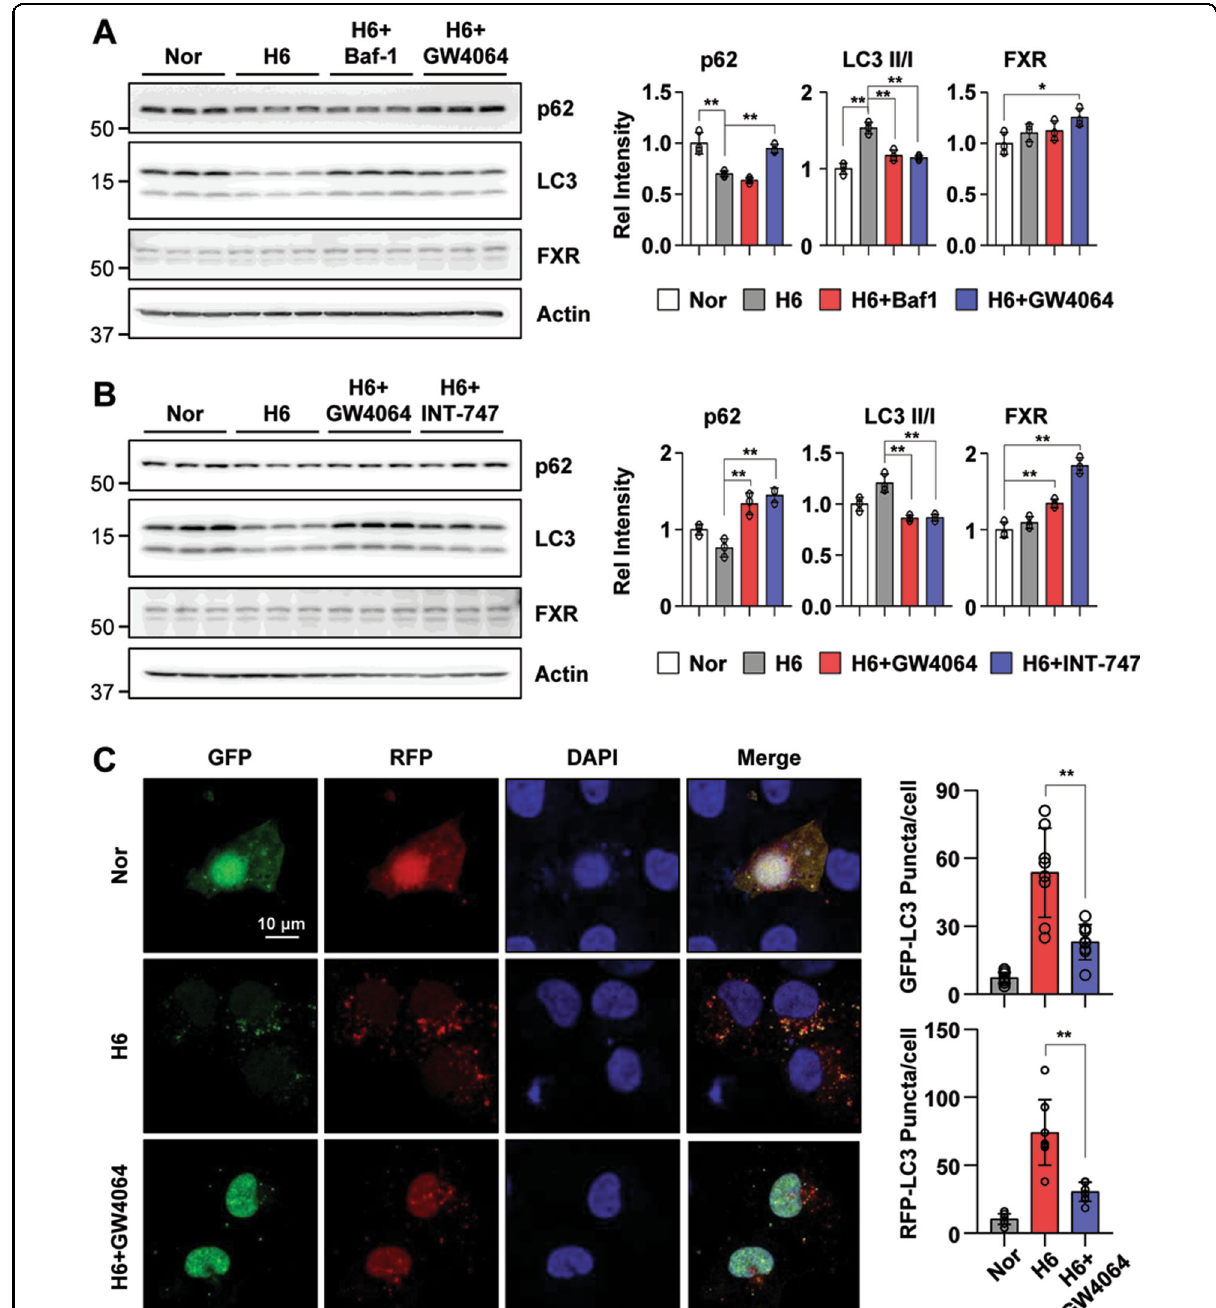
Fig. 3 Autophagy is inhibited by FXR activation in hypoxia-treated HK2 cells. A , B After treatment with Baf-1 (100 nM), GW4064 (500 nM), or INT-747 (500 nM) for 1 h, HK2 cells were exposed to hypoxia for another 6 h. The protein levels of p62, LC3, and FXR were detected by immunoblotting, and the relative levels of p62/Actin, FXR/Actin, and the LC3 II/I ratio are shown in the right top and right bottom panels, respectively ( n = 3). C HK2 cells were transfected with the ptf-LC3 expression plasmid. After treatment with GW4064 (500 nM) for 1 h, HK2 cells were exposed to with hypoxia for another 6 h. Fluorescence was imaged by confocal microscopy. The average number of LC3 puncta per cell is shown on the right ( n = 8). All values are presented as the mean ± SD. Statistical signi fi cance was measured using one-way ANOVA with the Bonferroni post-test. * P < 0.05, ** P <